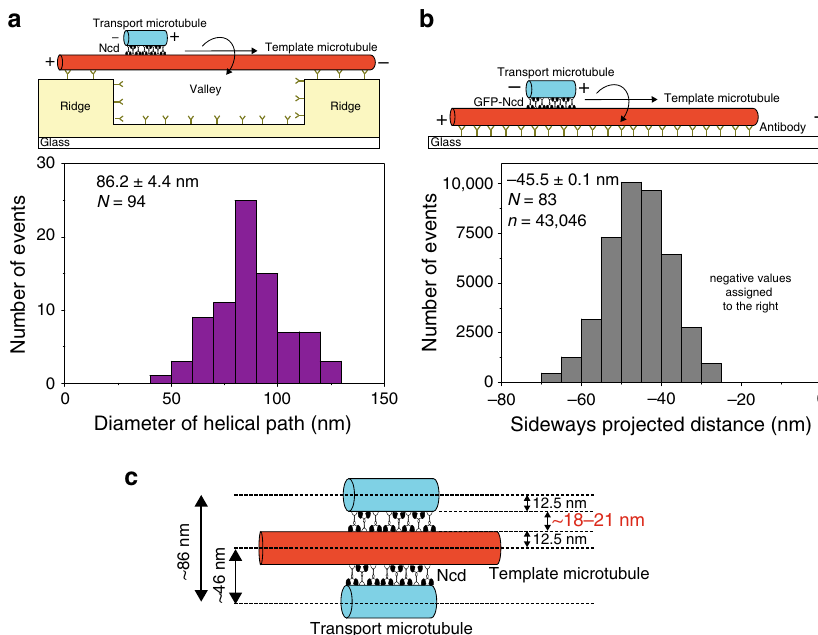
Fig. 3 Spatial extension of Ncd motors between sliding microtubules. a Histogram corresponding to the diameter of the helical trajectories taken by antiparallel transport microtubules rotating around suspended template microtubules (3D sliding motility assay). The average diameter was 86.2 ± 4.4 nm ( N = 94 events; see methods for analysis of distributions with error estimation). The mean diameter of the helical paths was calculated from the peak-to- peak sideways distances obtained from the trajectories of antiparallel transport microtubules. b Histogram corresponding to the sideways distance of antiparallel transport microtubules sliding along the right-hand side of surface-immobilized template microtubule (2D sliding motility assay). The average sideways distance was − 45.5 ± 0.1 nm ( N = 83 events; n = 43,046 data points). c As shown in the illustration, considering the diameter of the template and transport microtubule (25 nm), the in situ extension of Ncd motors was calculated to be about 18 and 21 nm for the 3D and 2D sliding motility assays,